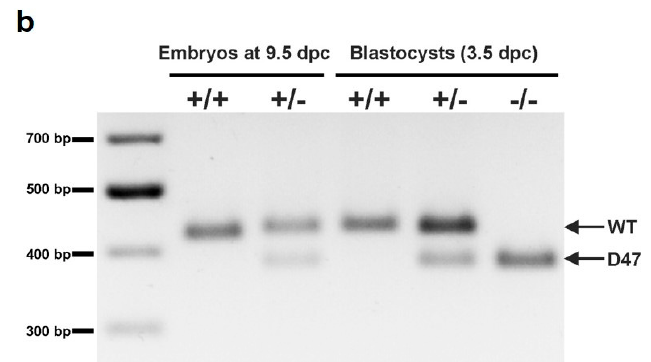
Figure 2. Genotyping of blastocysts. ( a ) Schematic representation of the used semi-nested design for genotyping. Introns are shown in blue, exons are shown in pink, and the CRISPR target site is shown in yellow. DNA isolated from blastocysts was subjected to PCR with primers (shown as arrows) adjacent to the CRISPR target site. The resulting amplicon was used in a second round of PCR with the same reverse and a nested inner forward primer to generate a 417 bp length product from the WT allele and a 370 bp product from the D47 allele. ( b ) Representative image of amplicons from semi-nested PCR visualized on agarose gel. The upper and lower band correspond to WT and D47 allele, respectively. Full-length agarose gel is included in the Supplementary Materials (Figure S7).